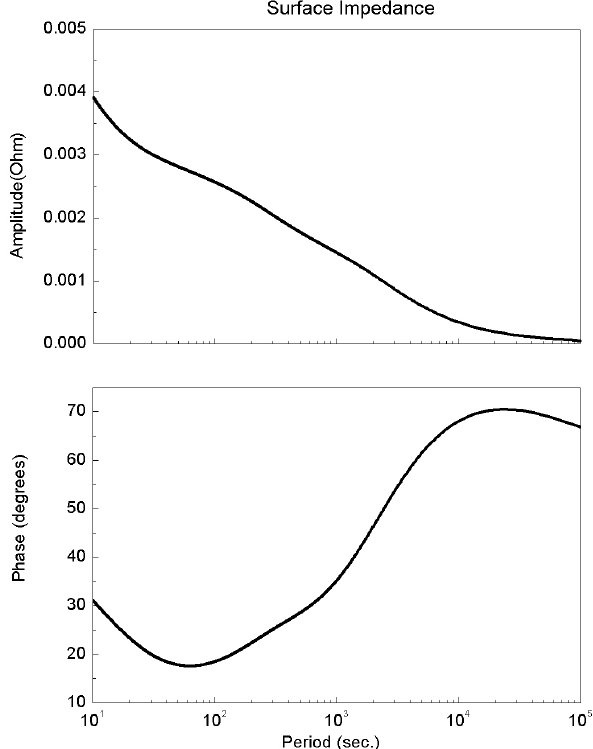
Fig. 3. Surface impedance for the layered Earth model shown in Fig.